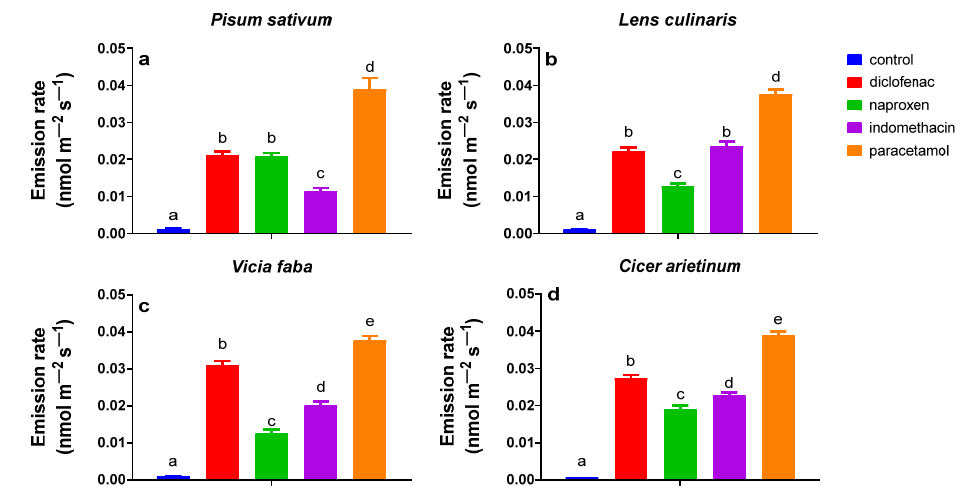
Figure 4. The emission rates of 1-hexanol from leaves from Pisum sativum ( a ), Lens culinaris ( b ), Vicia faba ( c ), and Cicer arietinum ( d ). Plants in 0.5 L pots filled with commercial garden soil were treated by watering 100 mL of 0.5 mg L − 1 NSAIDs every second day over a total of 20 days. The values are averages of three independent measurements. Data sharing different letters are significantly different ( p < 0.05), while data sharing the same letters are not significantly different ( p > 0.05).